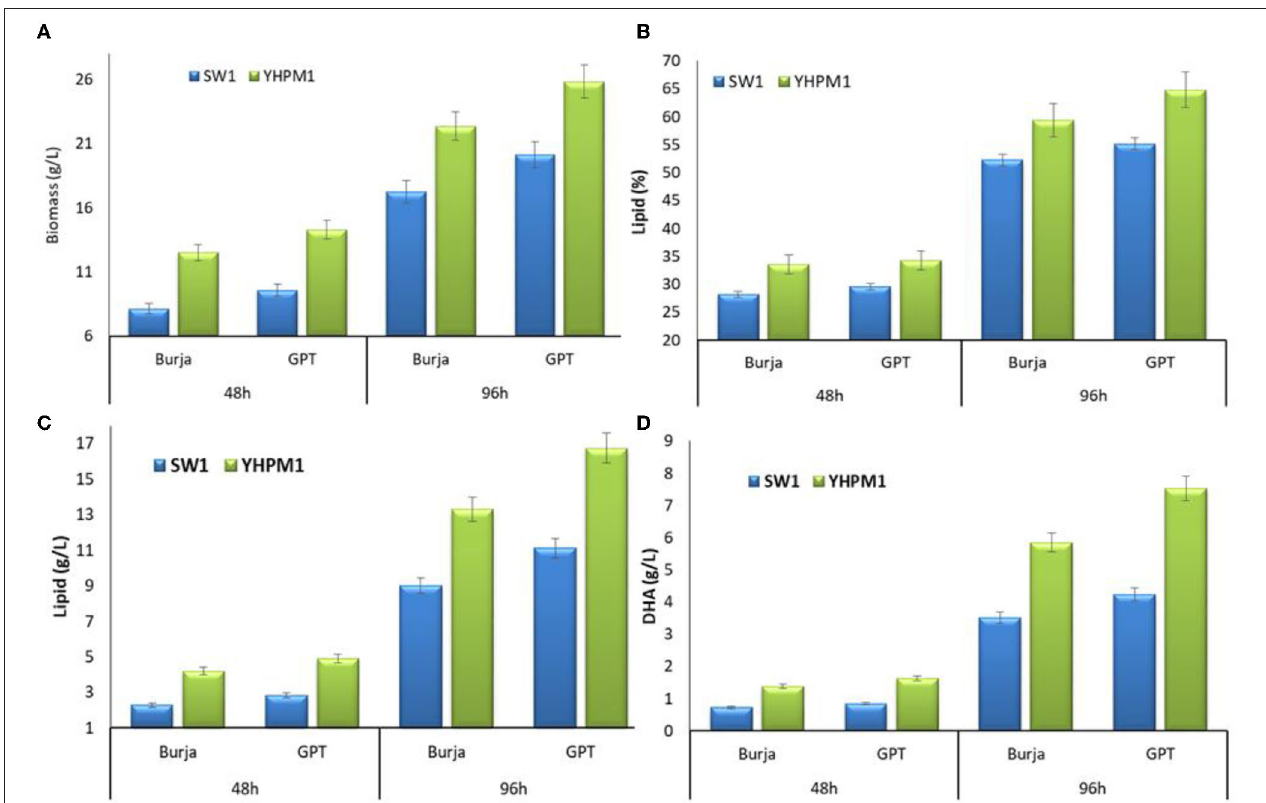
TABLE 1 | The fatty acid compositions of SW1 and YHPM1 cultured in 500ml shake flask for 48 and 96h of cultivation in Burja and GPT media. Fatty acids Burja